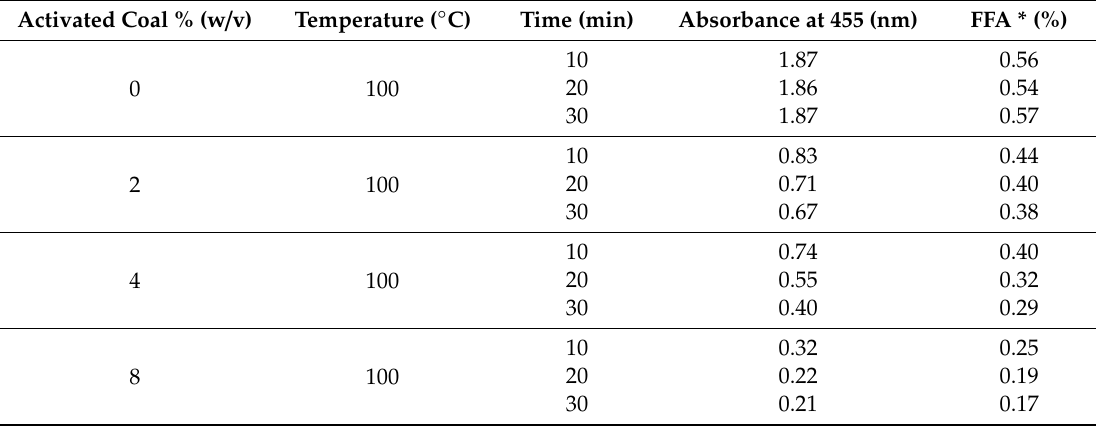
Table 1. Purification parameters of waste cotton seed oil (WCSO) using activated coal. Activated Coal % (w / v) Temperature ( ◦